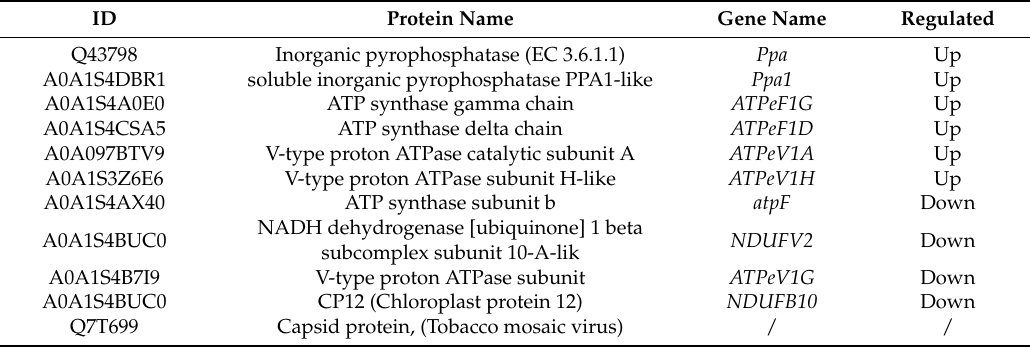
Table 2. Differentially expressed proteins that are involved in the oxidative phosphorylation pathway.